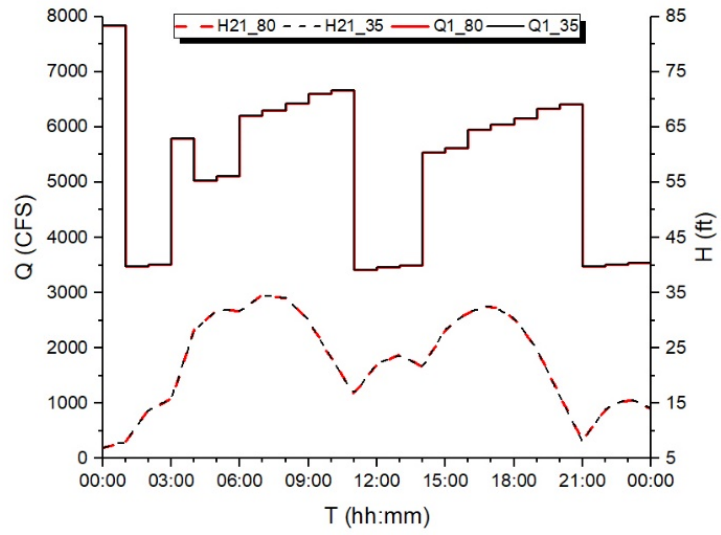
Figure 6. Results of the proposed pump scheduling methodology for Anytown network.